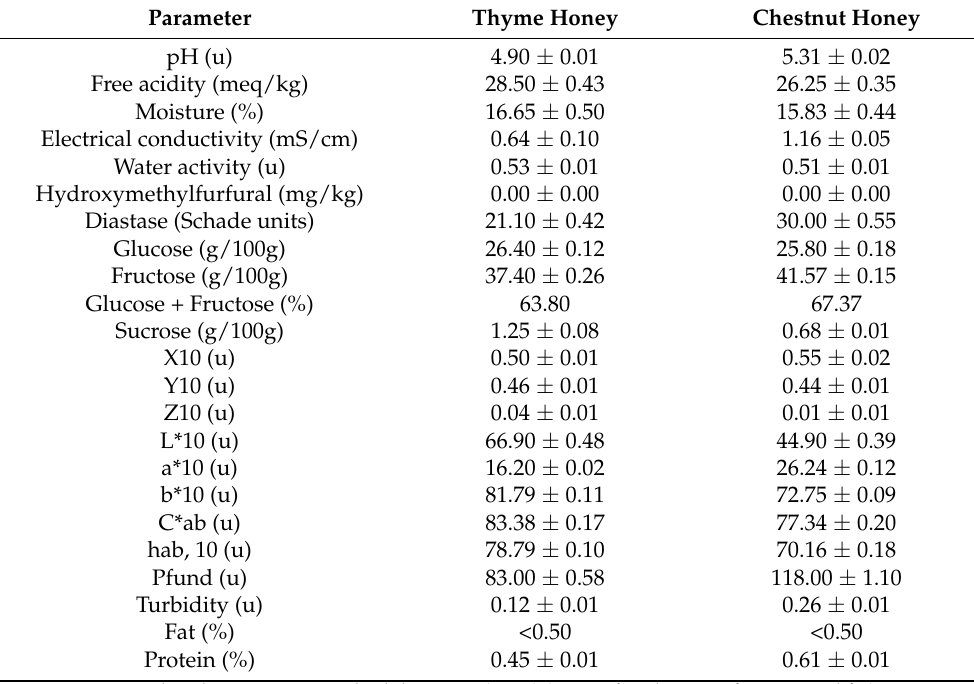
Table 3. Physicochemical properties of thyme and chestnut honey.